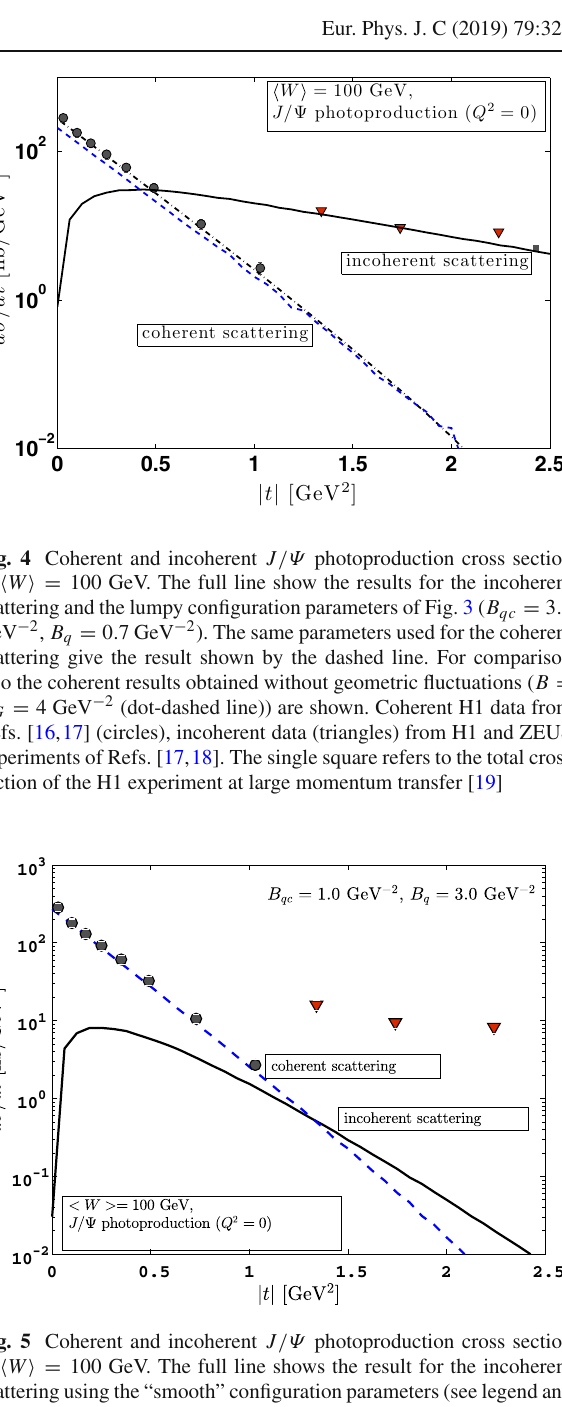
Gaussian parameters the values of Fig. 2 (i.e. B qc = 1 . 0